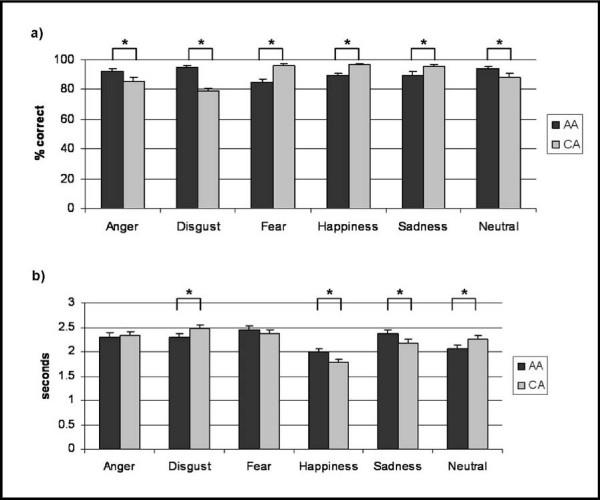
Emotion recognition accuracy (a) and reaction times (b) for all emotions for African American (AA) and Caucasian (CA) faces. Significant differences (p < 0.05) are marked by an asterisk.